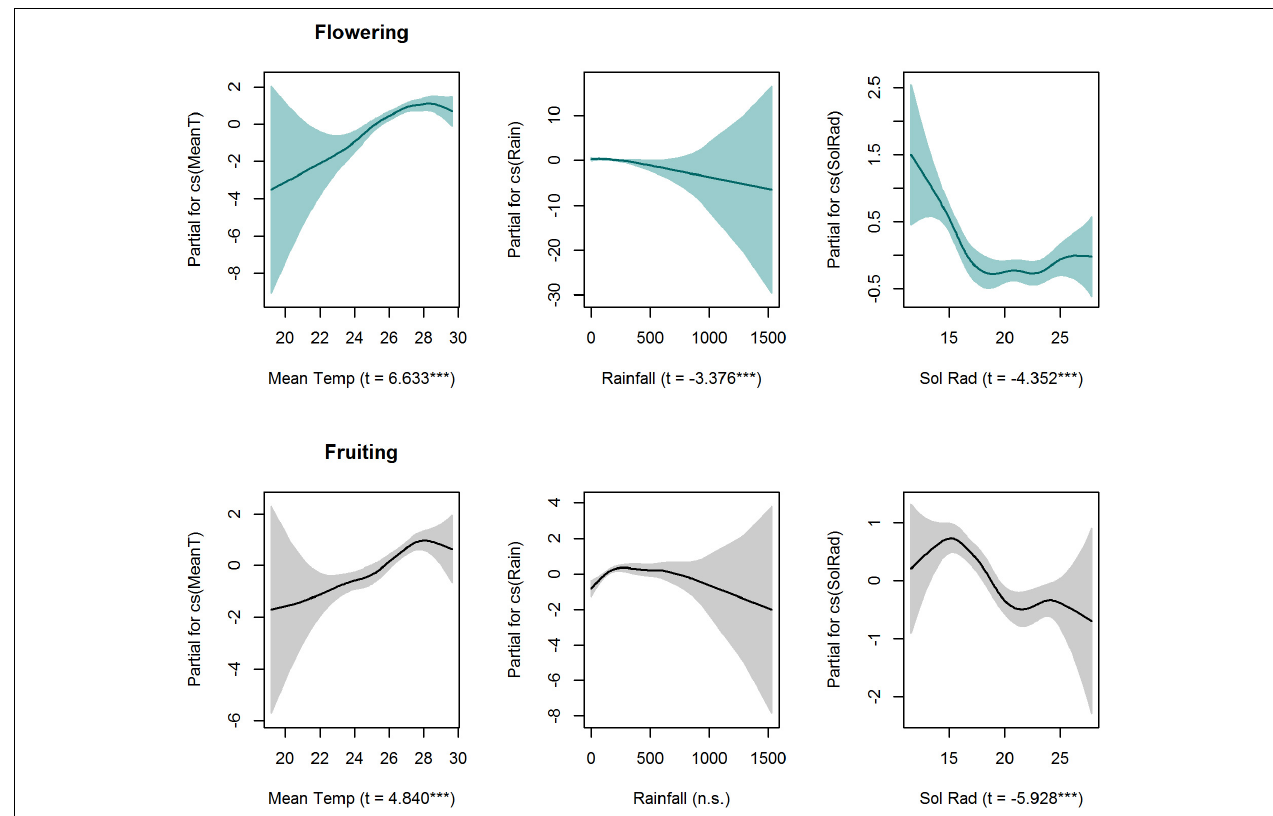
FIGURE 4 | Partial effects of GAMLSS explanatory variables on flowering and fruiting seasonal trends in a liana community (17 species) (Cox Snell R 2 0.48 and R 2 0.26, respectively), in Barron Gorge National Park, Far North Queensland, Australia. The shaded areas indicate the 95% confidence intervals. GAMLSS-smoother terms for total monthly rainfall (mm), mean monthly temperature ( ◦ C), and mean monthly solar radiation (MJ/m 2 ) were significant for flowering ( P < 0.05) whereas mean temperature ( ◦ C) and mean monthly solar radiation (MJ/m 2 ) were significant for fruiting. T -values and significance (*** P < 0.001) are presented within parenthesis in x -axis